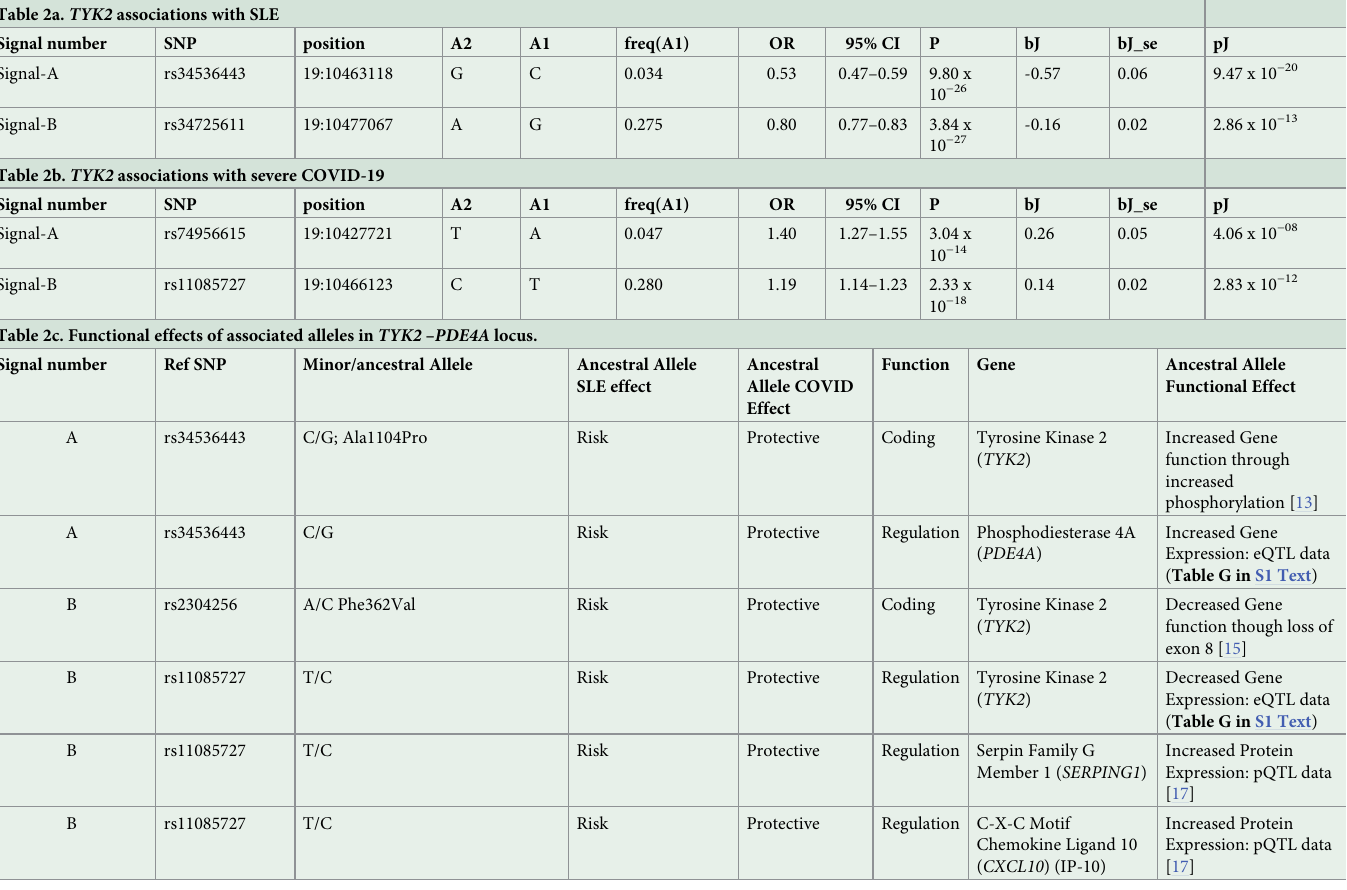
Table 2. TYK2 association results for a) SLE and b) severe COVID-19 data, and c) summary of functional effects of associated alleles. Independently associated SNPs in SLE and severe COVID-19 are displayed. Table 2a. TYK2 associations with SLE